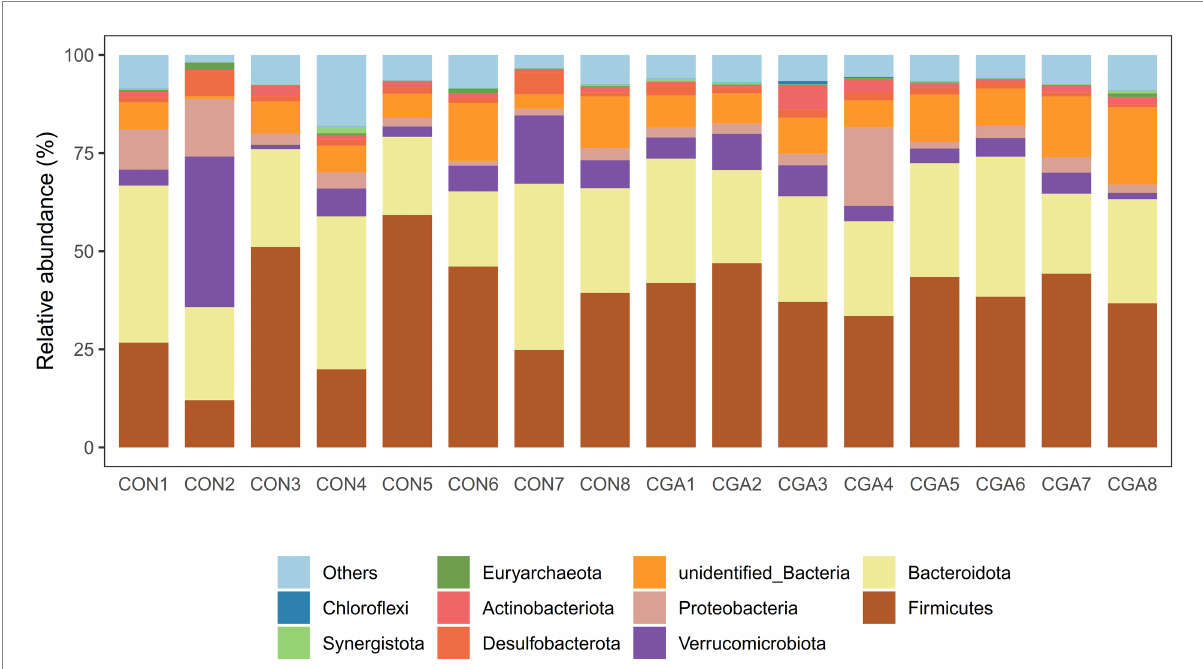
FIGURE 7 Bar graph shows the phylum level composition of bacteria. Color-coded bar plot shows the relative abundance of bacterial phylum across the different samples. CON 1, 2, 3, 4, 5, 6, 7, 8 are cecal digesta samples from rabbits fed with a basal diet; CGA 1, 2, 3, 4, 5, 6, 7, 8 are cecal digesta samples from rabbits fed with a basal diet supplemented with 800 mg/kg chlorogenic